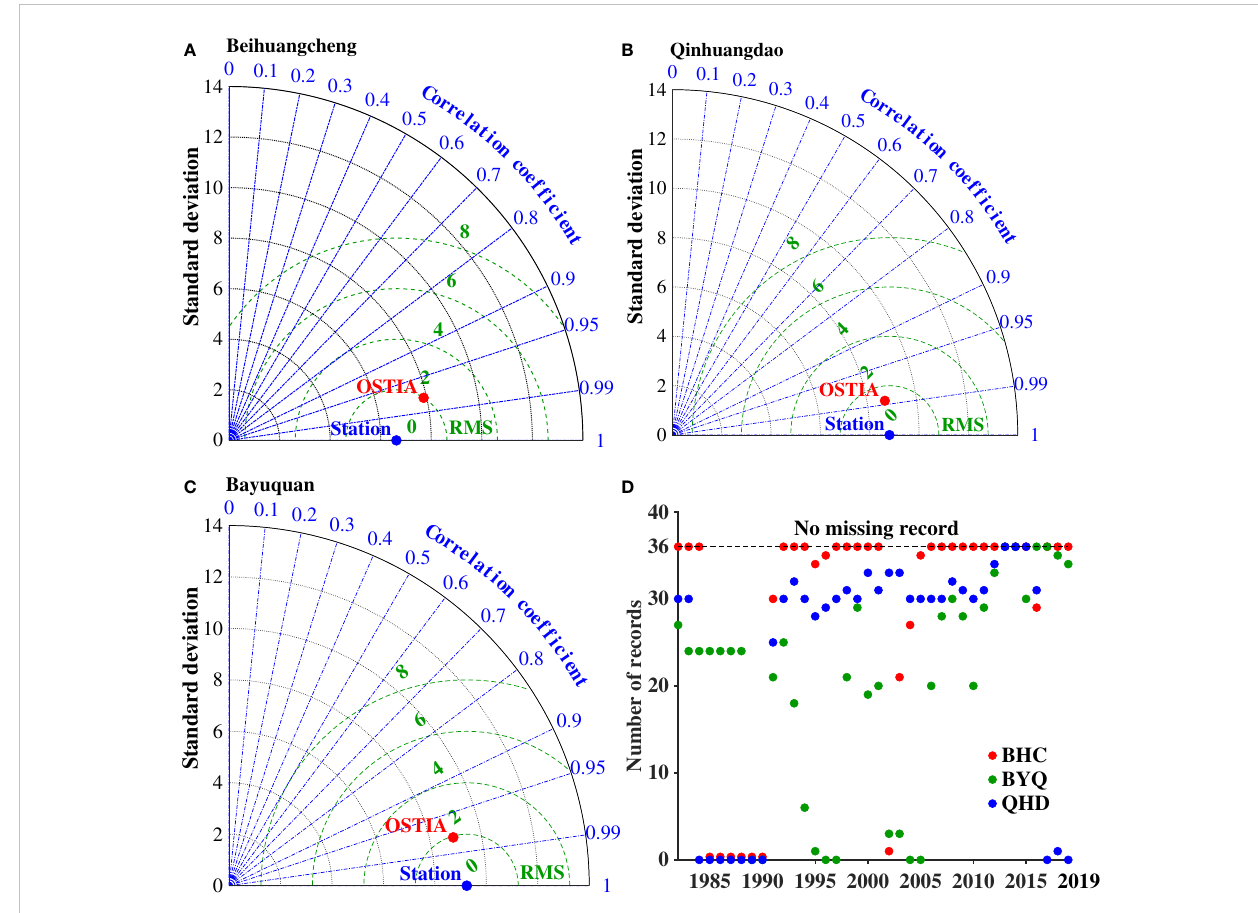
FIGURE 2 Taylor diagrams for the OSTIA SST time series compared with those of the in-situ observed SST at the oceanographic stations of (A) Beihuangcheng, (B) Qinhuangdao, and (C) Bayuquan. (D) illustrates the total number of observation records at each station during 1982 – 2019. In (D) , dashed line denotes the record number of 36 and means there are no missing record for a certain